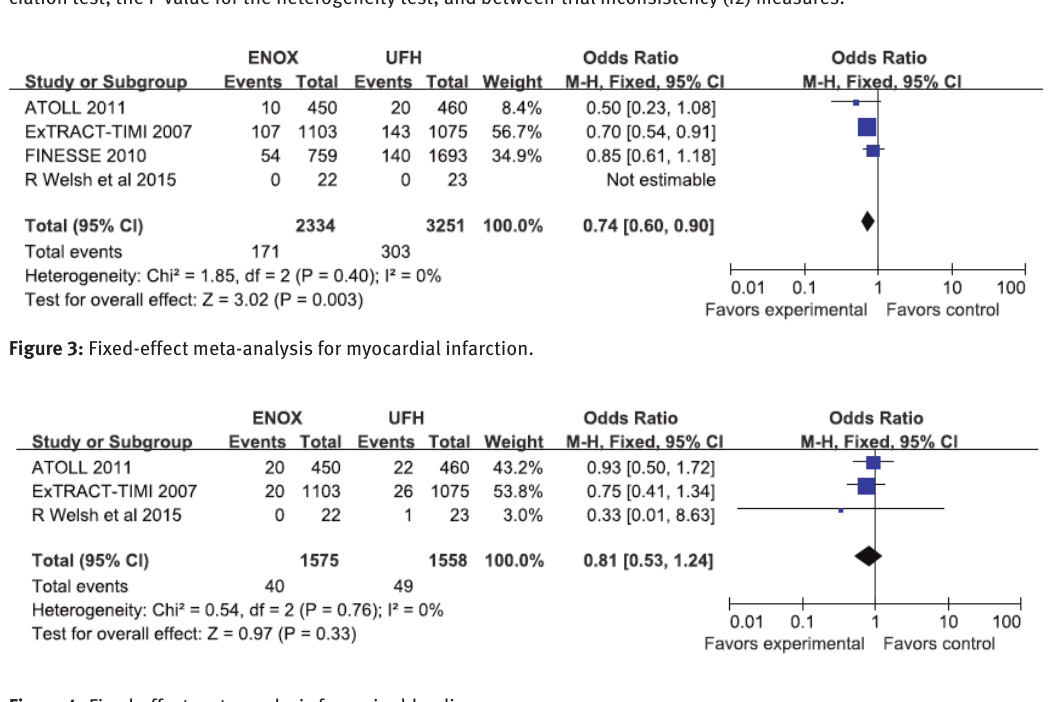
Figure 4: Fixed-effect meta-analysis for major